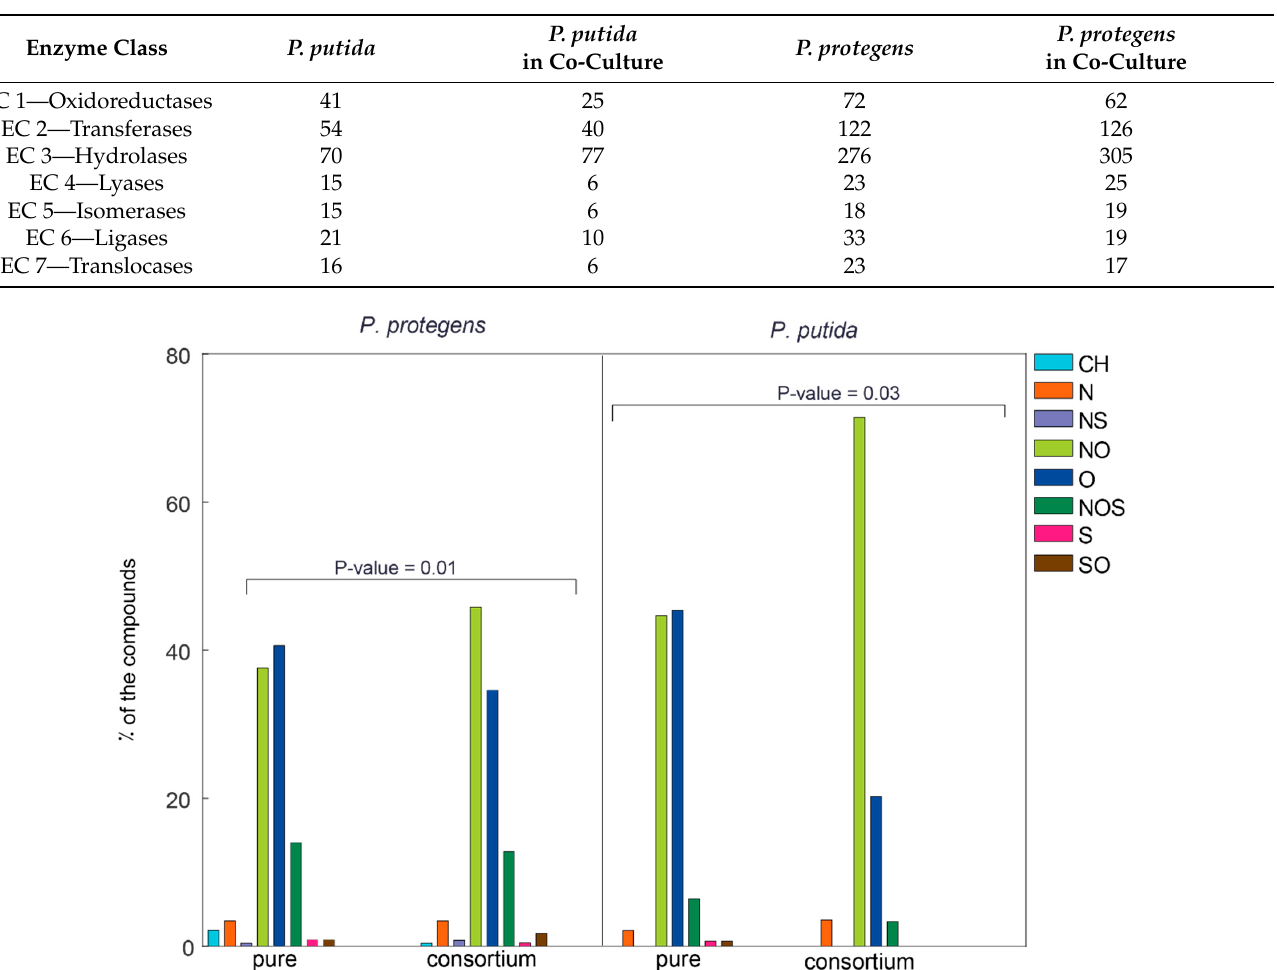
Table 1. Summary of the number of genes (categorized based on enzyme class) that are expressed by the three cultures in response to exposure to NAFCs.